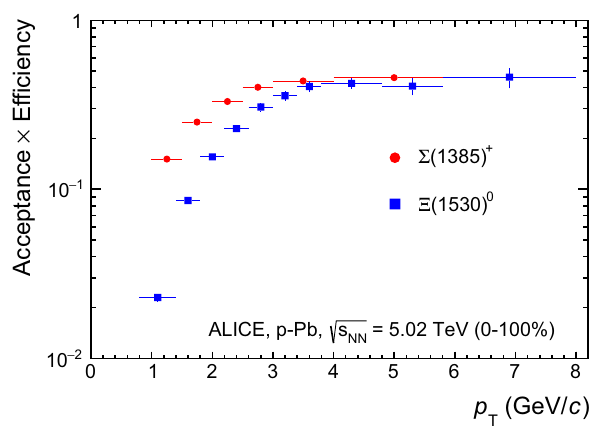
Fig. 4 The geometrical acceptance and the reconstruction efficiency < 0 for minimum-bias (A × ε ) for (cid:3) ∗+ and (cid:4) ∗ 0 in − 0 . 5 < y CMS MC events, obtained with DPMJET 3.05 [19] and GEANT 3.1 [27]. Only statistical uncertainties are